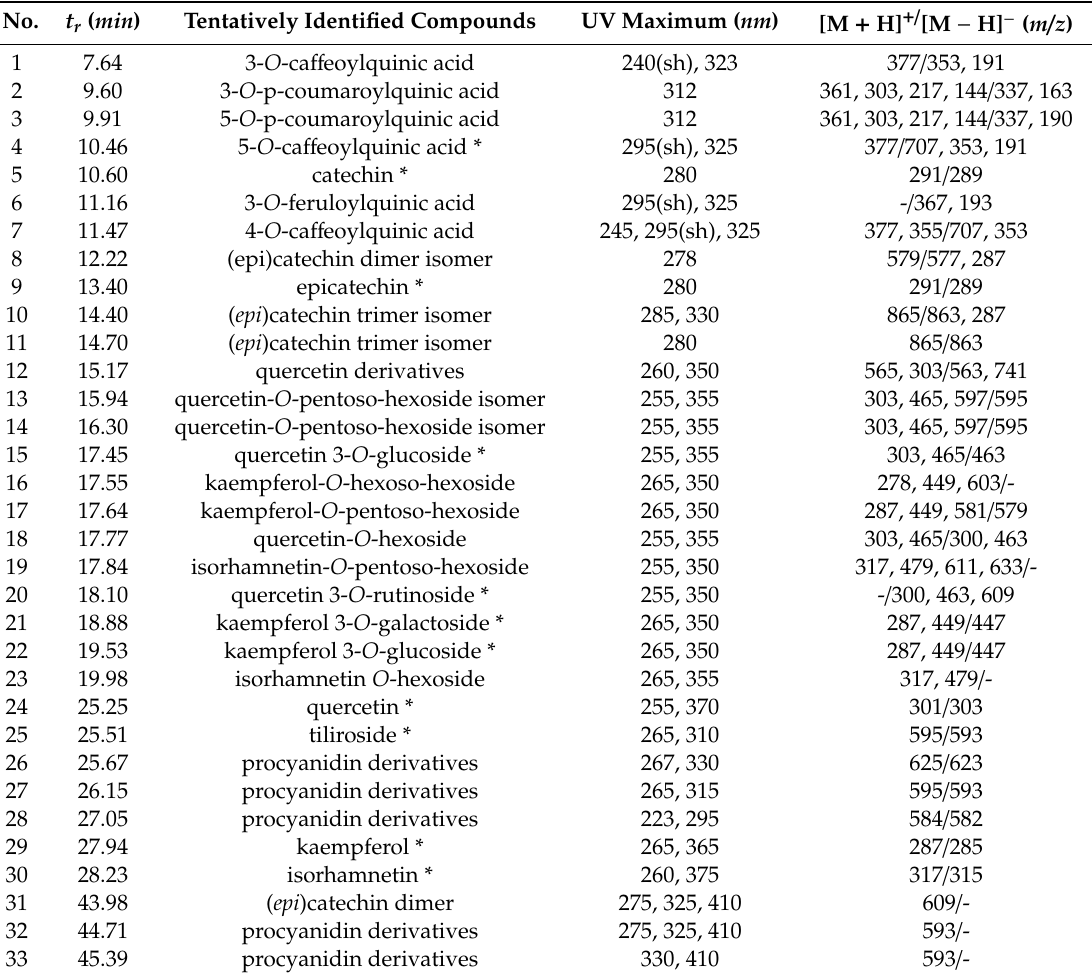
Liquid chromatography-photodiode array detection-electrospray ionization ion-trap time-of-flight mass spectrometry LC-PDA / MS-TOF identification of the major constituents of the analyzed PAL1–PAL7